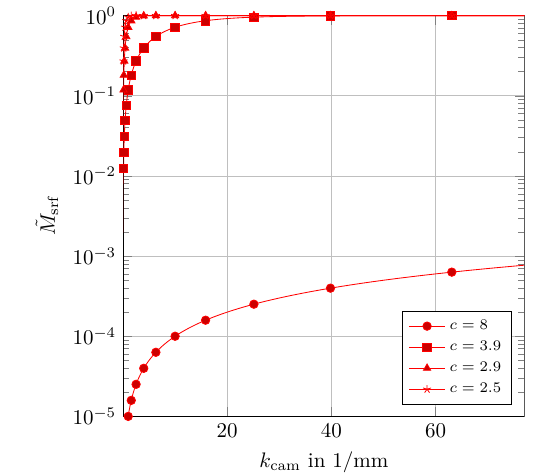
Figure 6. Lambertian surface MTF for different surface gloss pa-